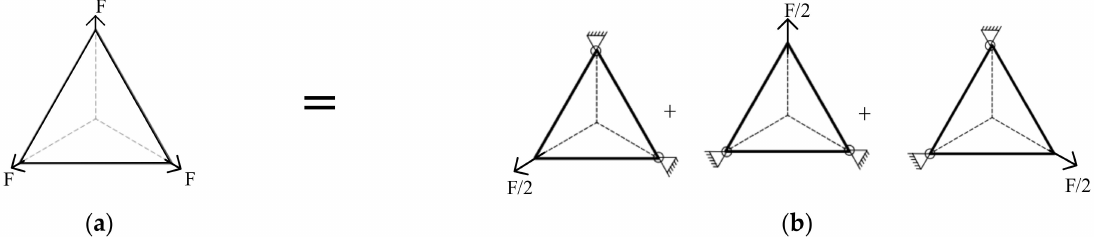
Figure 2. Triangular membrane stress superposition. ( a ) A plane membrane with three points subject to tension F; ( b ) Double point fixation, single point force F/2 of the plane